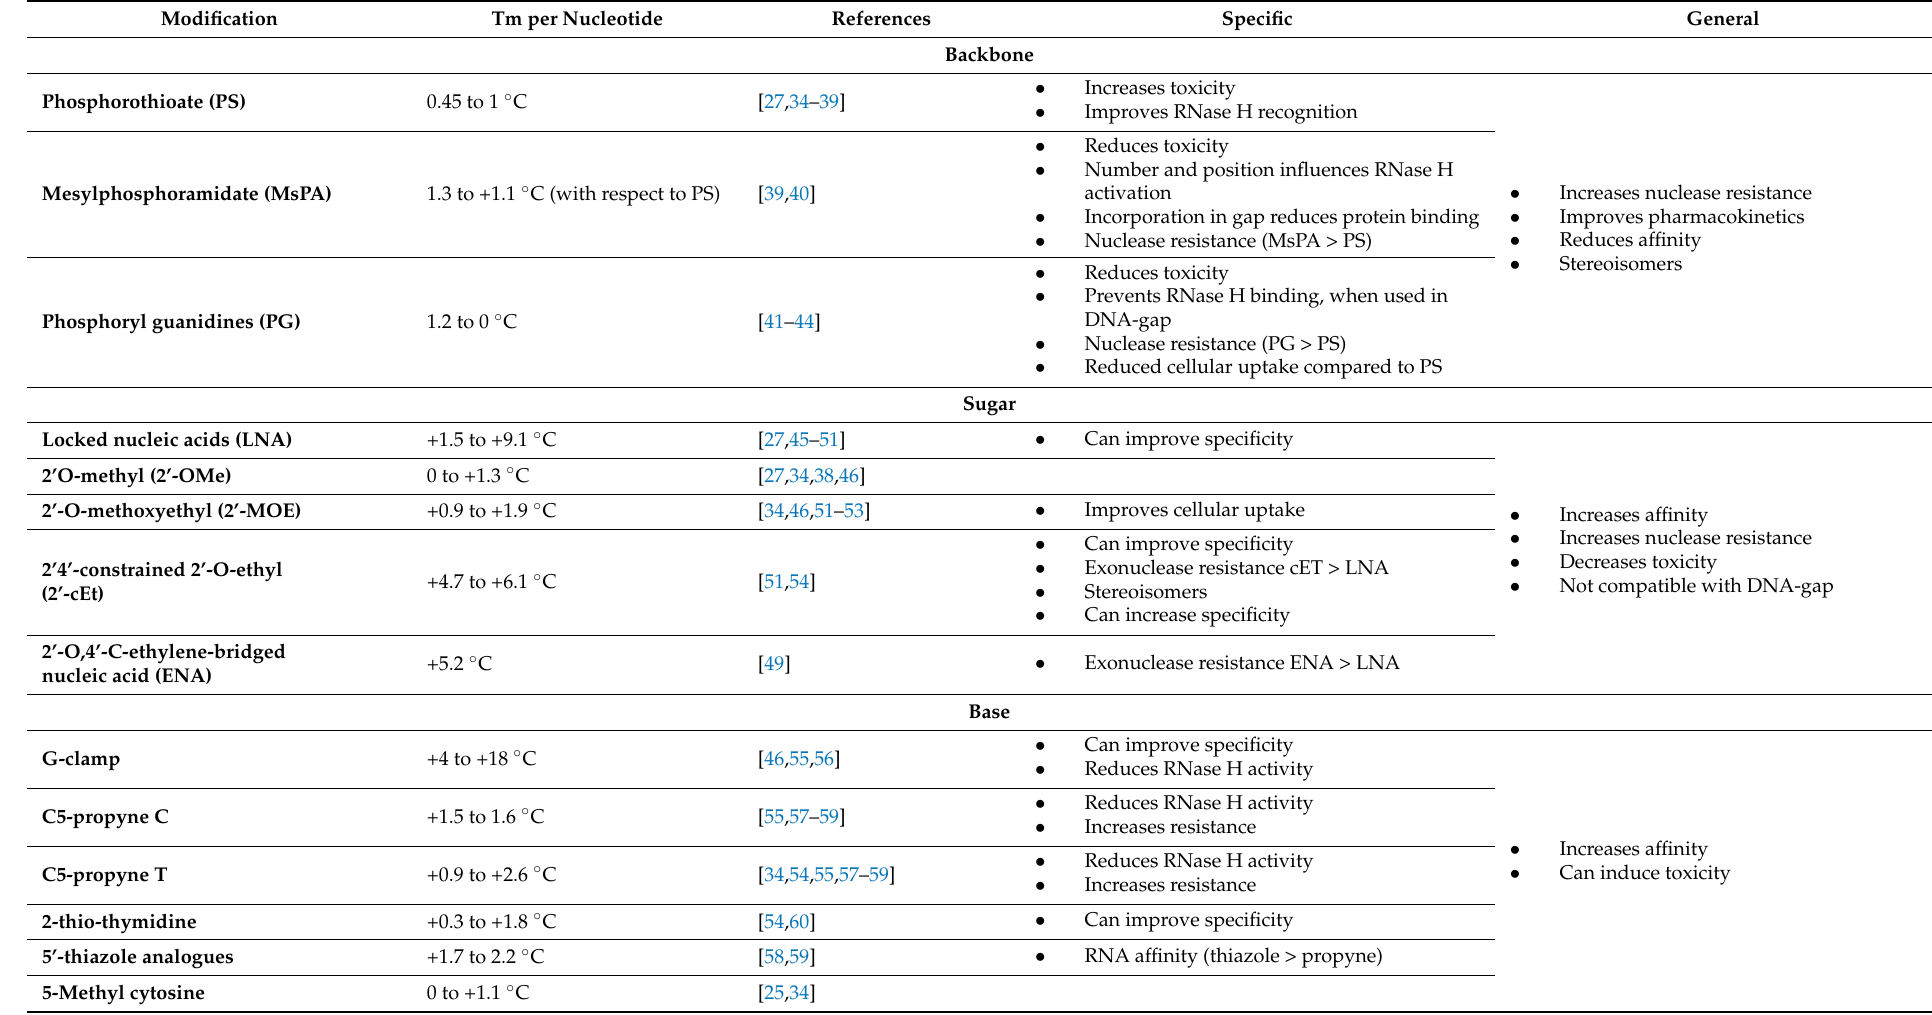
Table 1. Antisense oligonucleotide modifications and